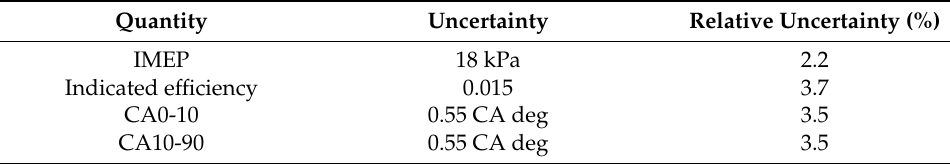
Table 6. Uncertainty for indirectly measured